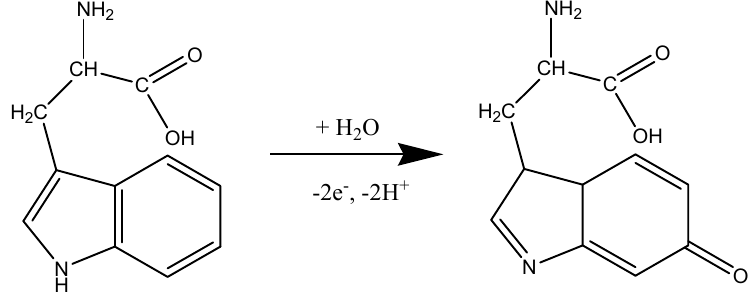
Figure 7. Cyclic voltammetry (CV) recorded with graphene ‐ modified electrodes in solutions containing 10 − 4 M L ‐ tryptophan in PBS solutions of various pH: 6, 6.5, 7, 7.5, and 8 ( a ). Variations of the peak current (I peak ) with the solution pH ( b